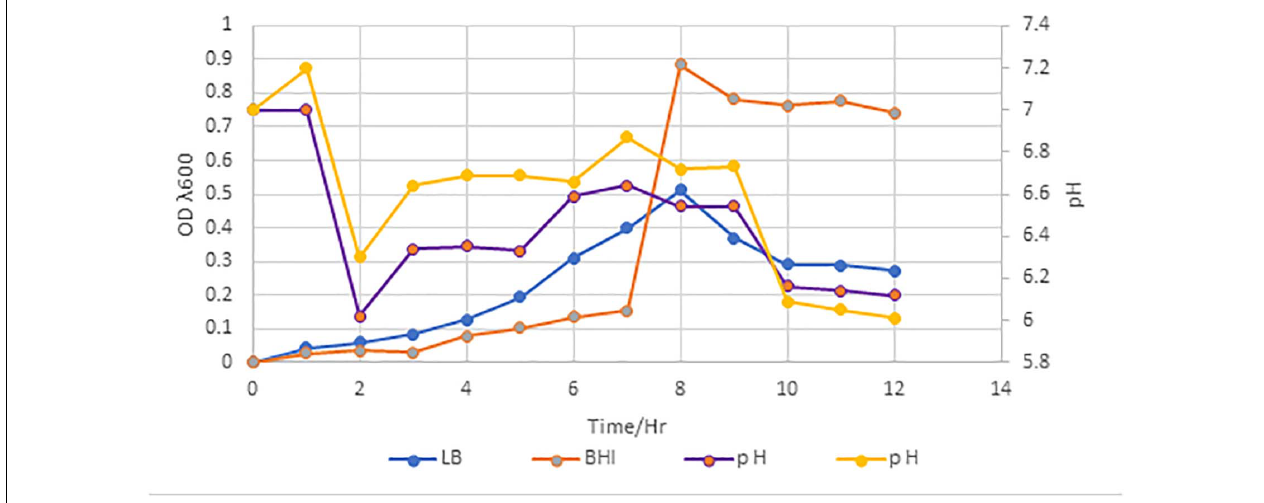
FIGURE 1 | Growth curve of P. peoriae IBSD35 in BHI and LB broth media, and their OD and pH after 12 h incubation. A customize graph with three axes; a bottom X axis, one left Y axis and right Y axis. The X axis represents the time, and the left Y axis represents the OD. The right Y axis represents the pH (LB, Luria Bertani; BHI, brain heart infusion; OD, optical